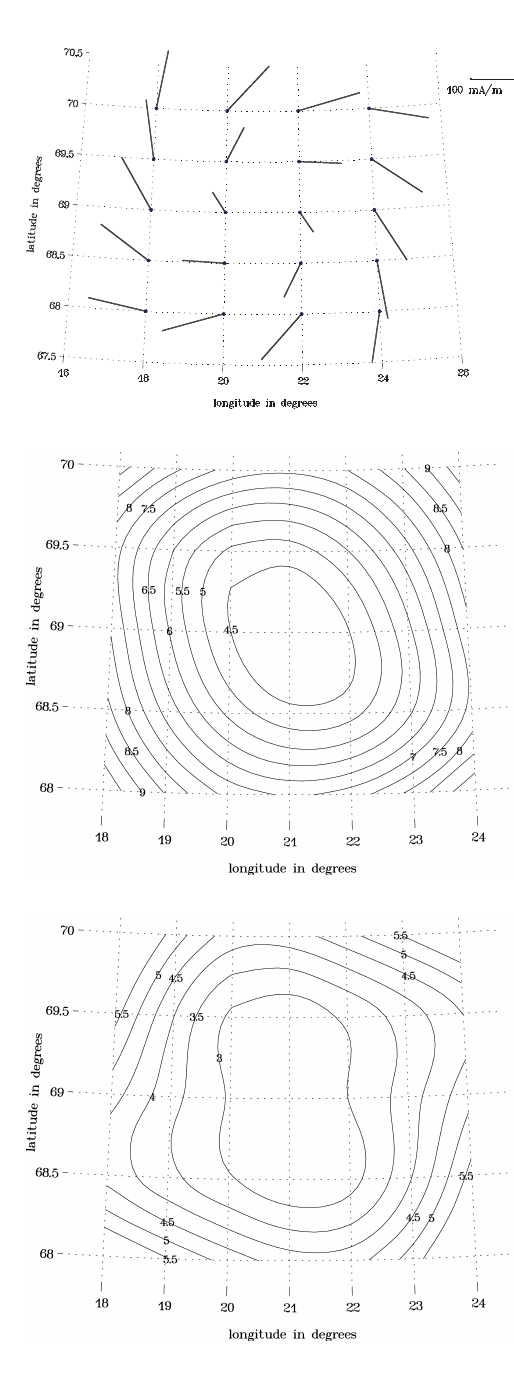
Fig. 4. Original model (left) and results of the elementary current method (right). From top to bottom: True ionospheric currents, Hall conductance (in siemens) and Pedersen conductance (in siemens). Reproduced from Figs. 3 and 5 of Amm